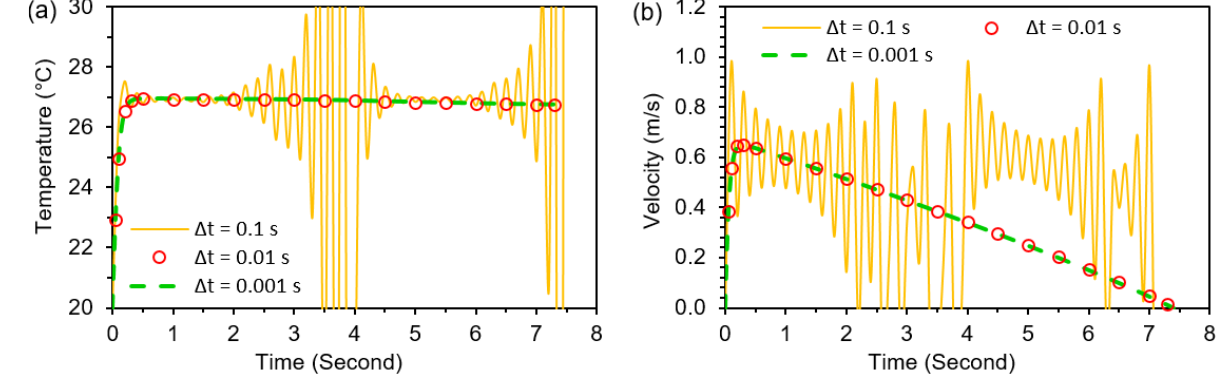
Figure 2. Sensitivity analysis of the computational model; ( a ) temperature ( T ), and ( b ) velocity ( v ).